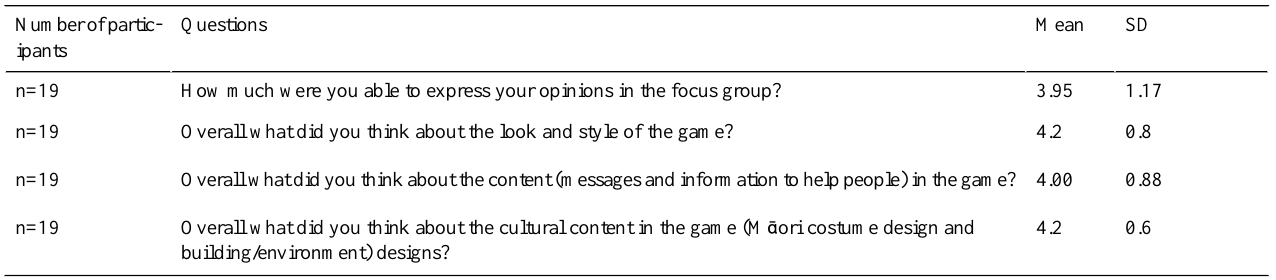
Table 3. Results of focus group questionnaire. SDMeanQuestionsNumber of